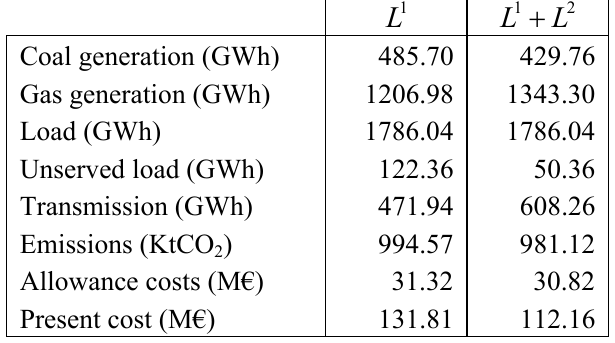
Table 12. Expansion from 1 L to 21 LL  under higher initial allowance price.